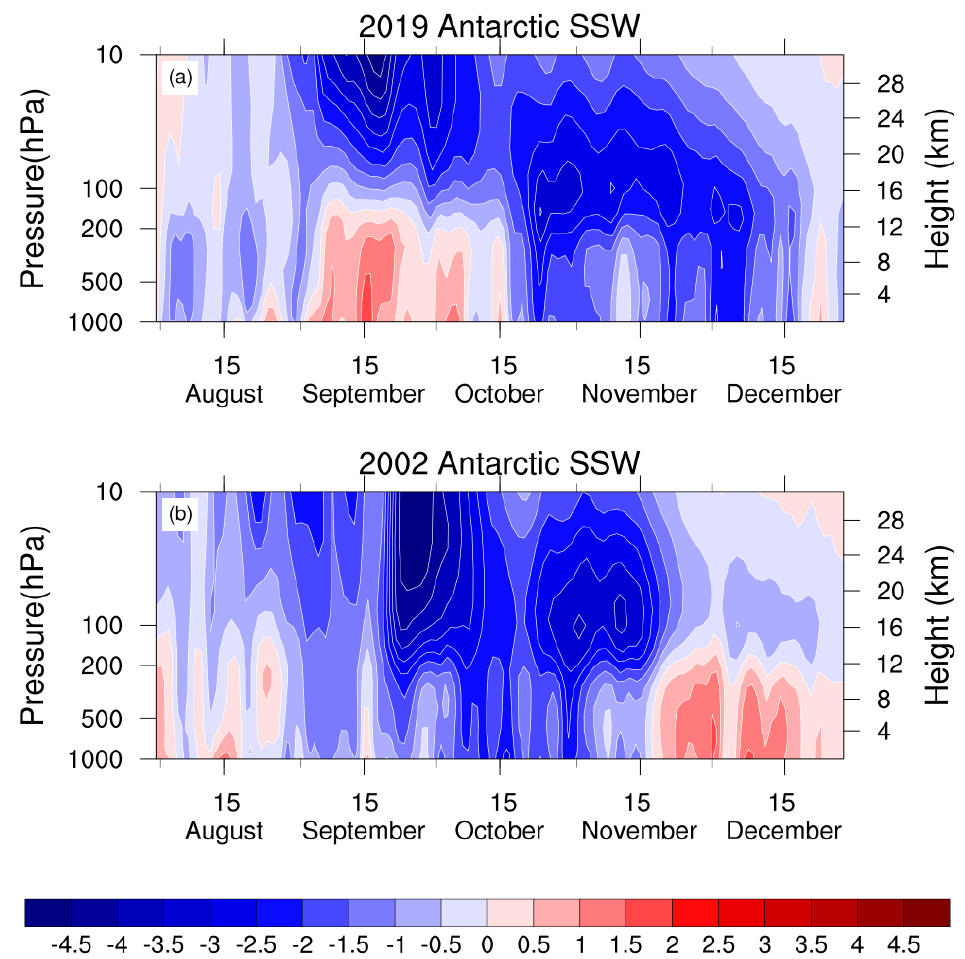
Figure 3. Time-height cross sections of daily SAM index from 1 August to 31 December in ( a ) 2019 and ( b ) 2002. The contour intervals in both ( a ) and ( b ) are 0.5.